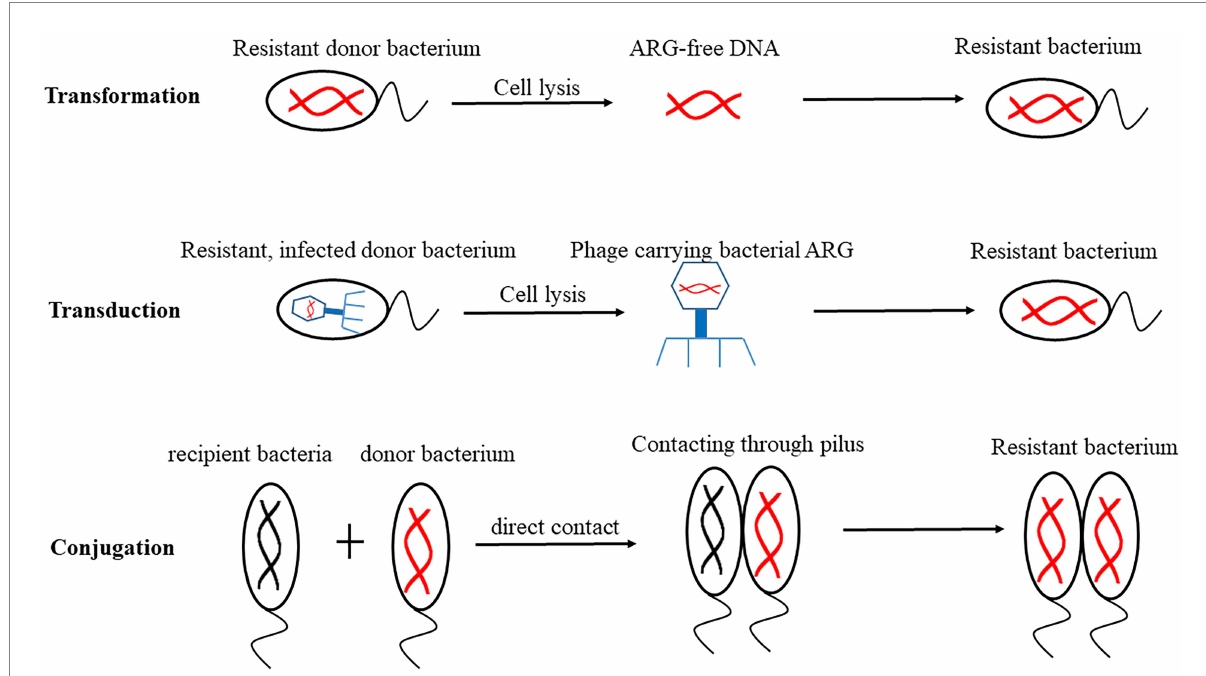
FIGURE 2 Mechanisms of horizontal gene transfer (HGT). Transformation refers to that the receptive receptor bacterial cells embed the free antibiotic resistance genes (ARGs) into the bacterial chromosome, integrate and stable express. Transduction refers to transfer ARGs from donor bacteria to recipient bacteria by phage. Conjugation refers to transfer of ARGs through sexual pili during direct contact between donor and recipient